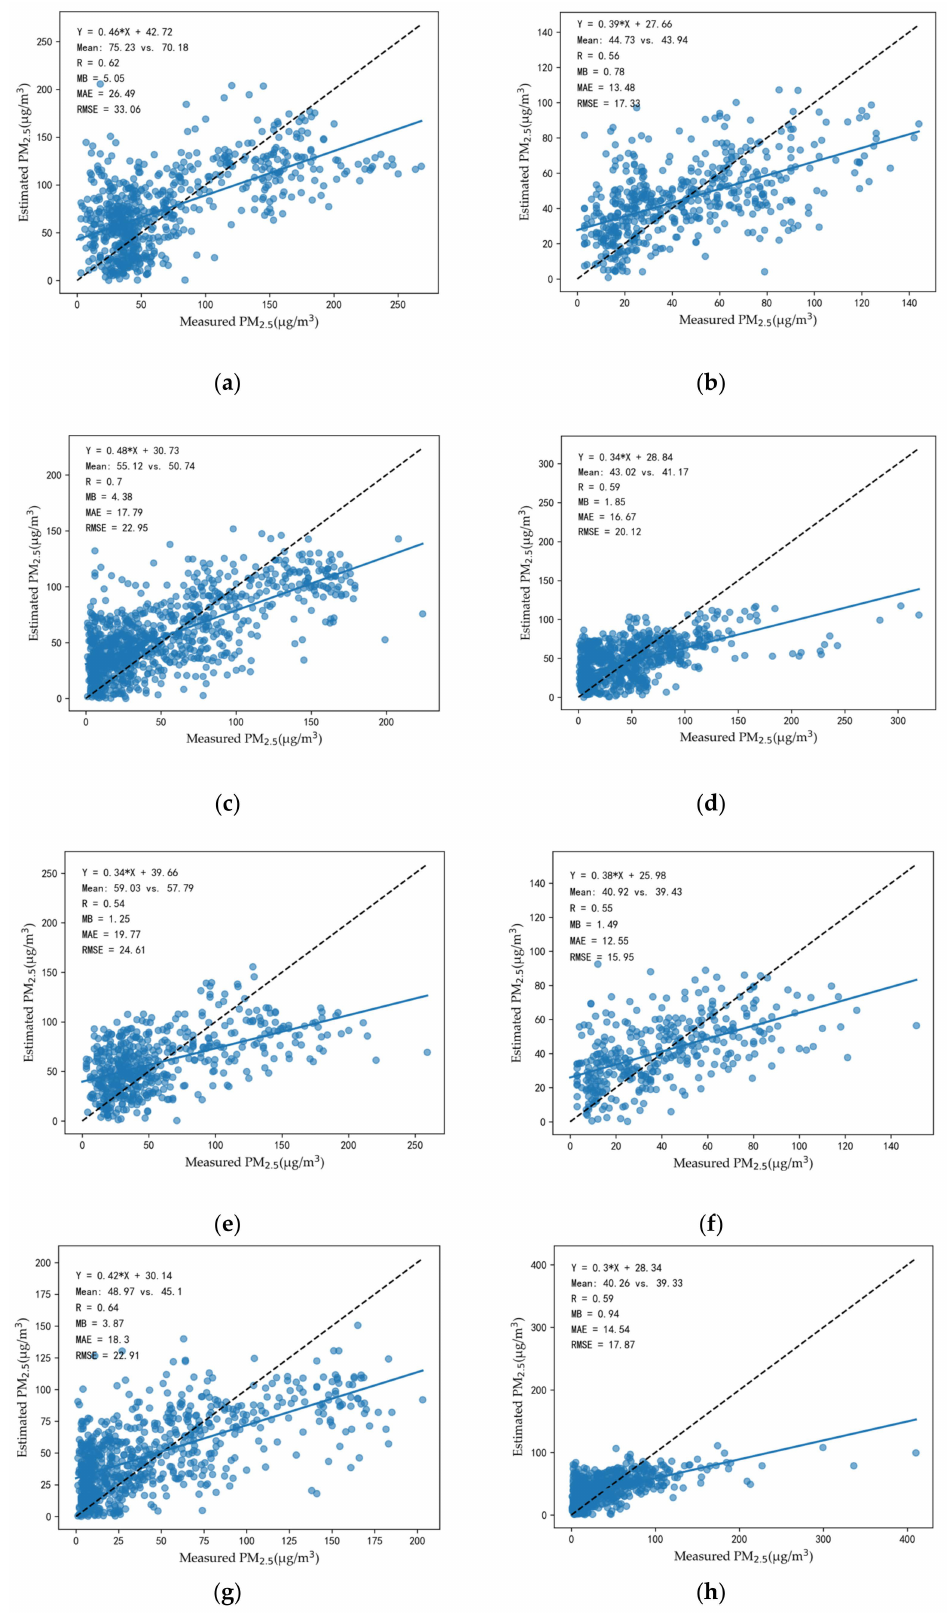
Figure 6. Scatter plots of estimated PM 2.5 and measured PM 2.5 without considering VZA in the urban area and the suburbs: ( a – d ) is in spring, summer, autumn, and winter of the urban area, respectively; ( e – h ) is the same in the suburbs. The dashed line is the 1:1 line as a